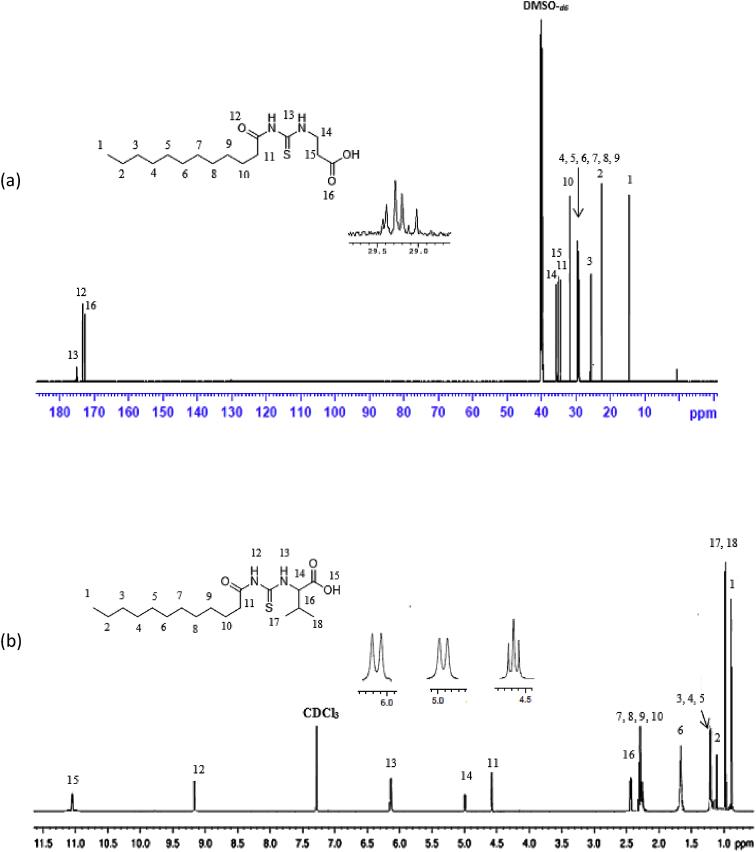
1H NMR spectra for (a) R1 (b) R2 (c) R3 and (d) R4.